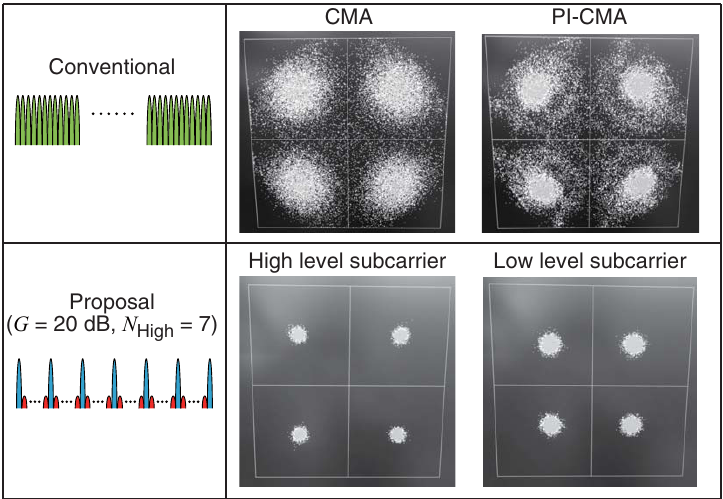
Figure 7. In-phase and quadrature (IQ) constellation by BAA at SIR total = 0 dB ( G = 20 dB and N High =